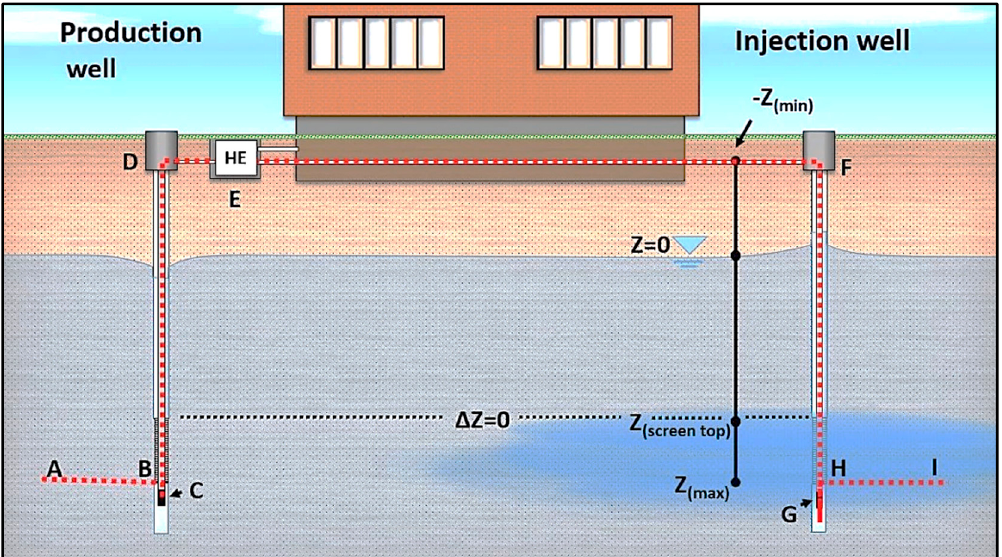
Figure 8. GWHP design concept. The heat exchanger is located outside the building in separate housing close to the production well. The slightly longer indirect loop of secondary fluid connects the heat pump to the groundwater. The depths of both well screens are equal.